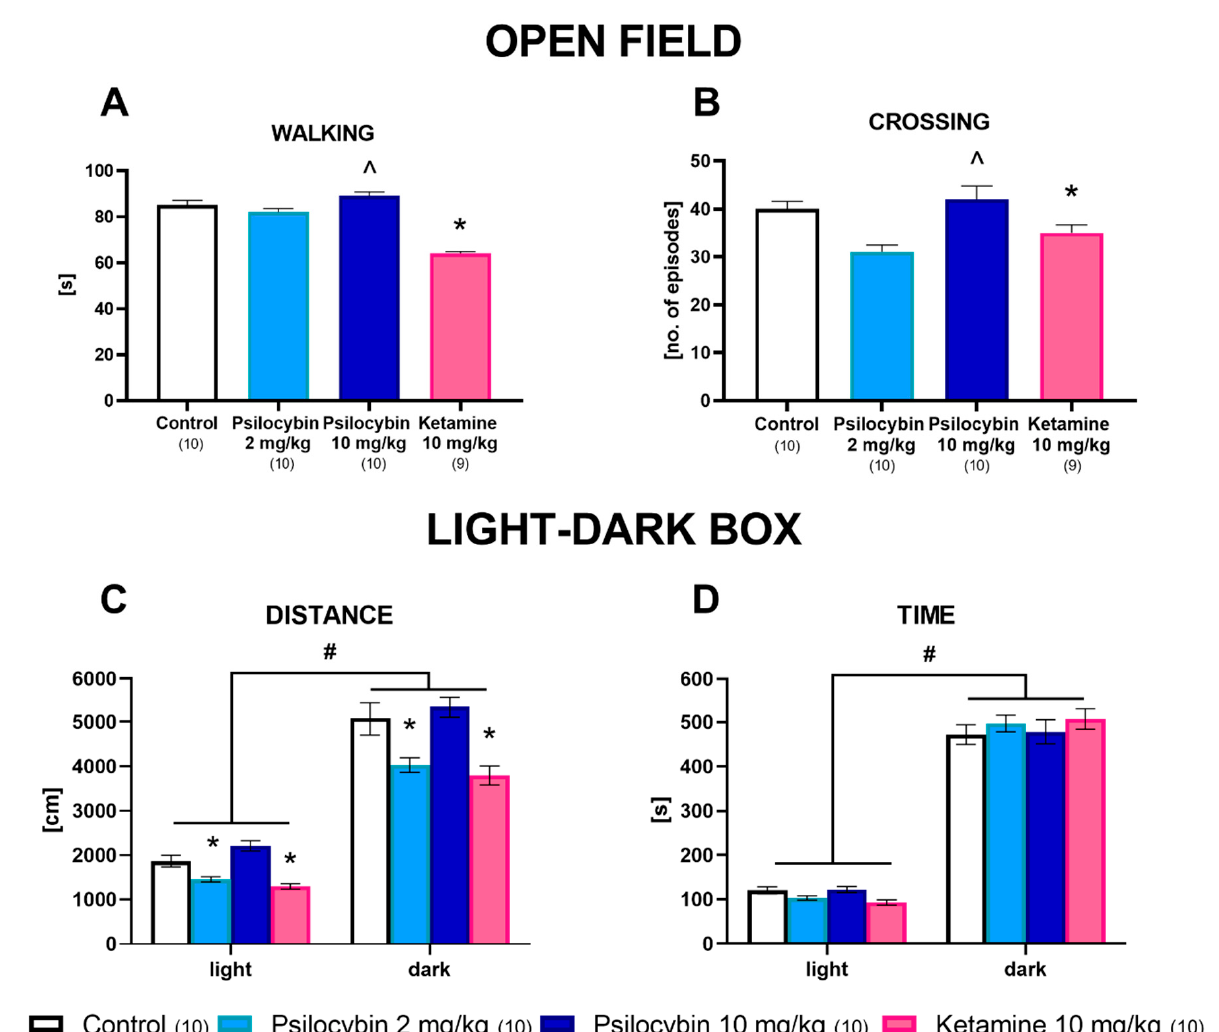
Figure 5. The effect of psilocybin (2 and 10 mg/kg) and ketamine (10 mg/kg) on locomotor behavior in the open field test (OF) and on activity of rats in the light–dark box (LDB) test 24 h after administration. The time spent on walking ( A ), the number of crossing episodes (B ) in the OF test and ambulatory distance ( C ) and time spent ( D ) in the light and dark zone in the LDB test. Values are the mean ± SEM (n is given under or next to the name of the group). * p < 0.001–0.05 compared to the control; ^ p < 0.05 psilocybin 2 mg/kg compared to psilocybin 10 mg/kg; # p < 0.001 light vs. dark (one ‐ way ANOVA or two ‐ way ANOVA followed by Tukey’s post hoc test).